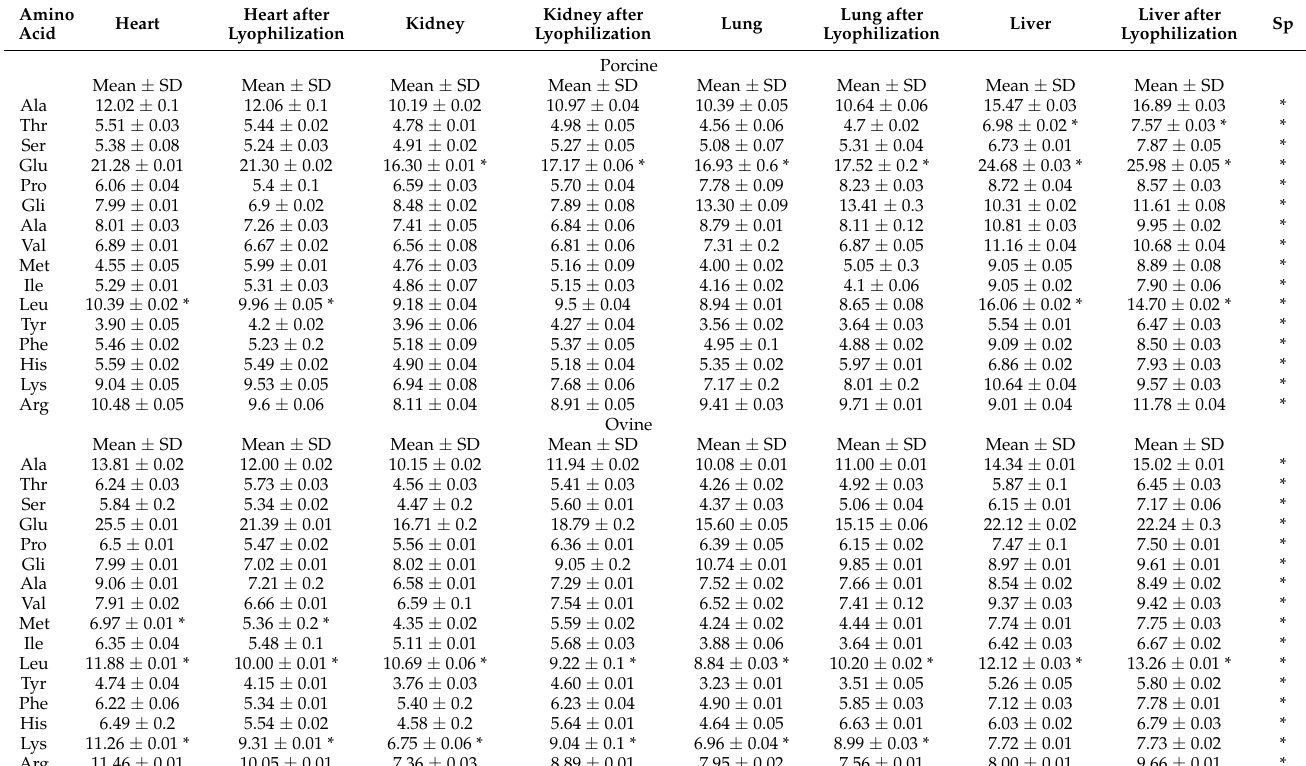
Table 2. Amounts of amino acids in raw and lyophilized meat by-products (g/kg of dry